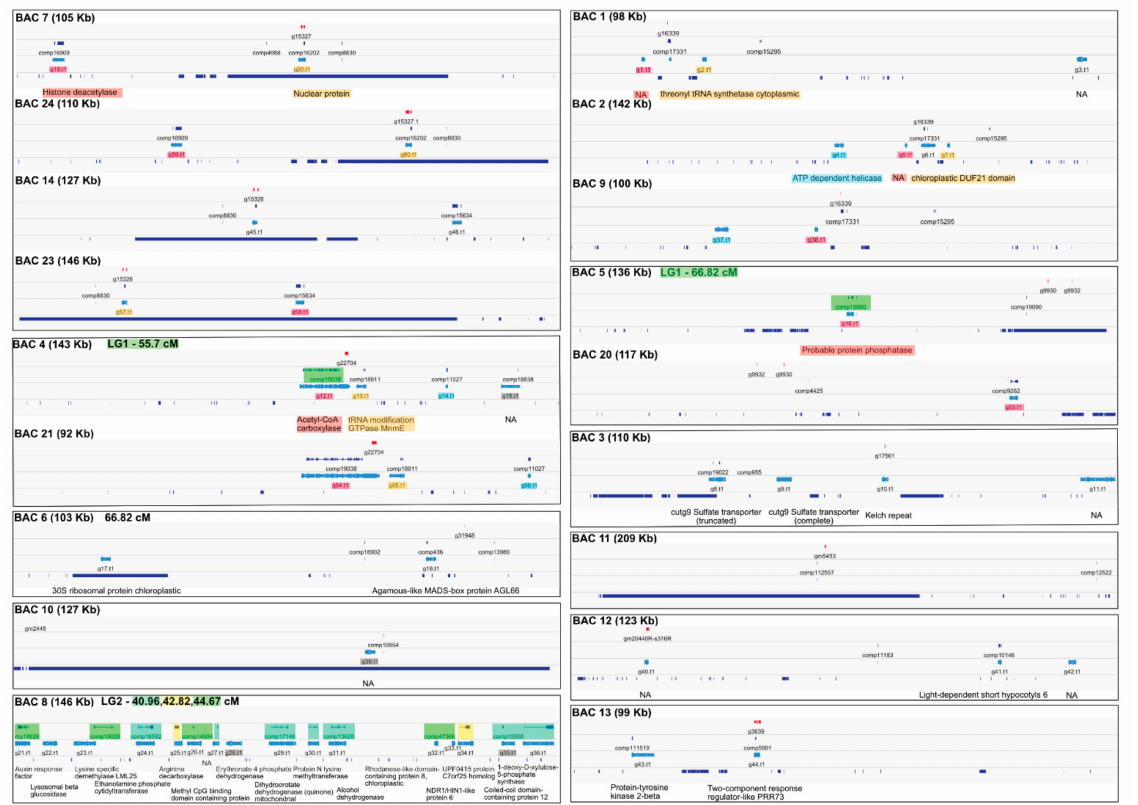
Figure 2. Graphical summary of the assembled BACs. Each assembly is annotated with the male-specific PCR product location (red), ORF BLAT hits (top dark blue), Augustus gene predictions on the repeat masked assembly (light blue), and BLAT hits from the M. annua repeat library (bottom dark blue). Each group of non-overlapping BACs is surrounded by a black box. Identical predicted gene models are indicated by overlaid colored boxes, for visual alignment of BACs containing the same genes. Green overlaid boxes indicate mapped ORFs that also map to the BACs, and their female recombination map position. Only genes with gray overlaid boxes were not expressed at all in the RNAseq experiments. The names displayed under the gene predictions are from their first blastp hit to the non-redundant (nr)protein database. Note the BAC contigs are not illustrated at the same